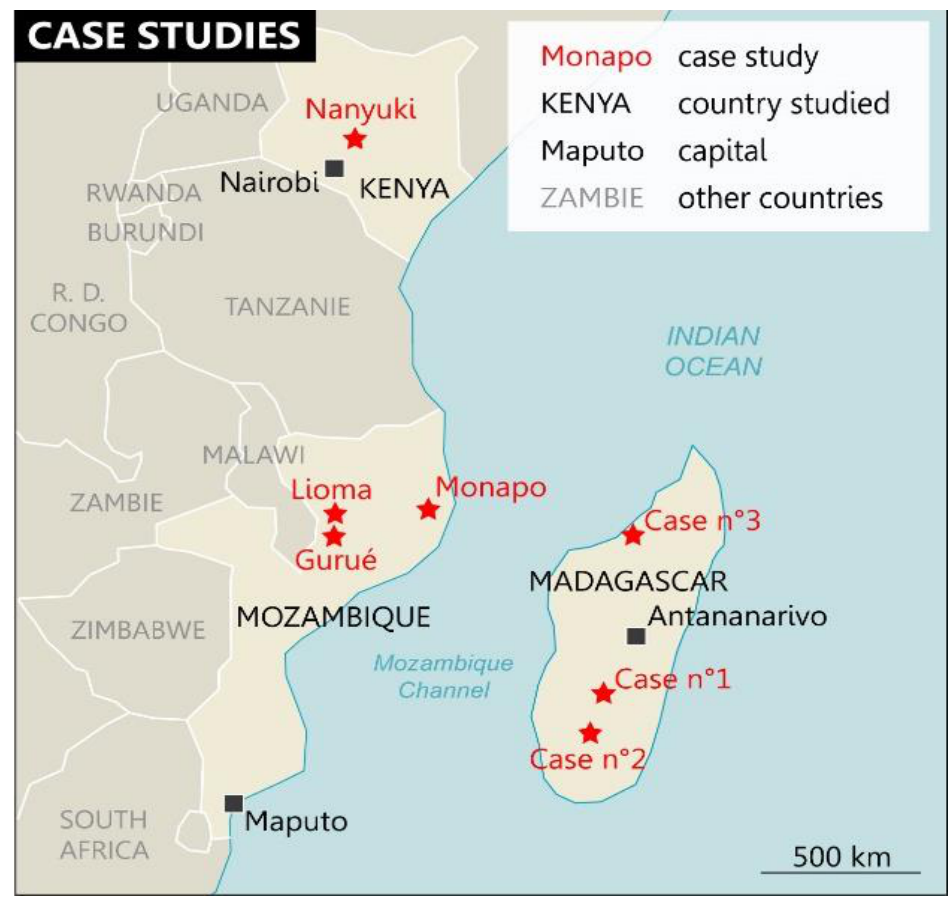
Figure 1. Study areas in the three countries. “Reprinted with permission from Reys [45–47]. 2021, Aur é lien